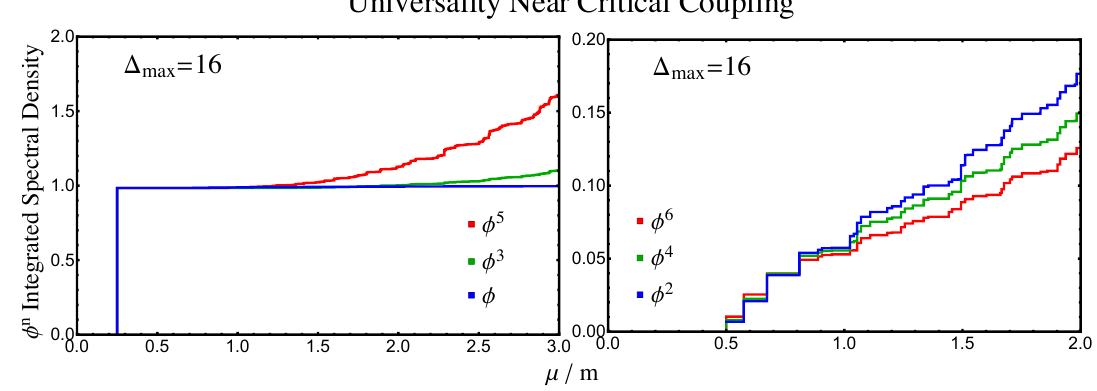
Figure 10 . Integrated spectral densities of φ 2 n − 1 (left) and φ 2 n (right) near the critical point at ¯ g ≈ 1 . 03 (where 2 µ = µ = 0 . 5 ; see footnote 13). The agreement in the IR signals 1 -part. /m 2 -part. /m universal behavior.